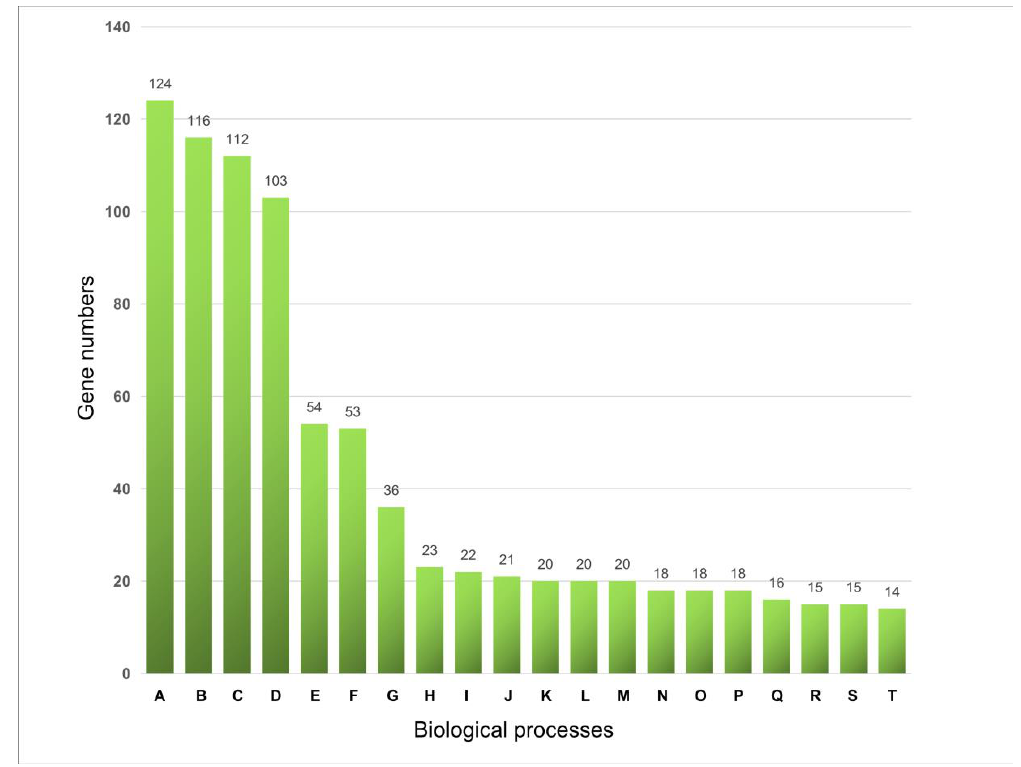
Figure 1. Gene Ontology (GO) functional enrichment analysis of the interspaced repeat sequence (IRS)-related genes in Arabidopsis. GO enrichment analysis was performed using the online server (http://geneontology.org). Approximately 914 mapped IDs and results only for uncorrected p < 0.05 were displayed. The top 20 biological processes are shown here. A: developmental process; B: anatomical structure development; C: multicellular organismal process; D: multicellular organism